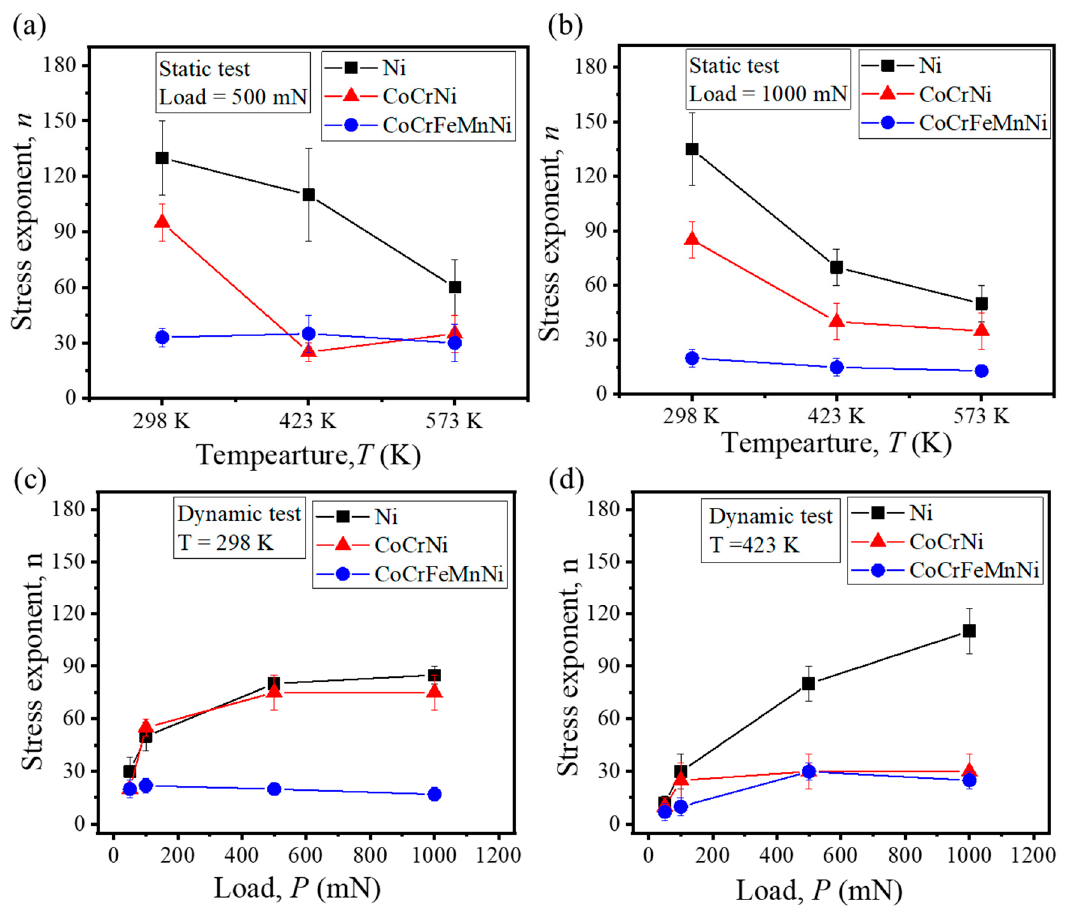
Figure 4. Stress exponent versus temperature from static test for Ni, CoCrNi and CoCrFeMnNi alloys at ( a ) 500 mN and ( b ) 1000 mN showing decrease of stress exponent with increasing temperature for Ni and negligible dependence of stress exponent on temperature for CoCrFeMnNi HEA. Stress exponent versus load from dynamic test for all alloys at ( c ) 298 K and ( d ) 423 K showing indentation size effect for stress exponent.